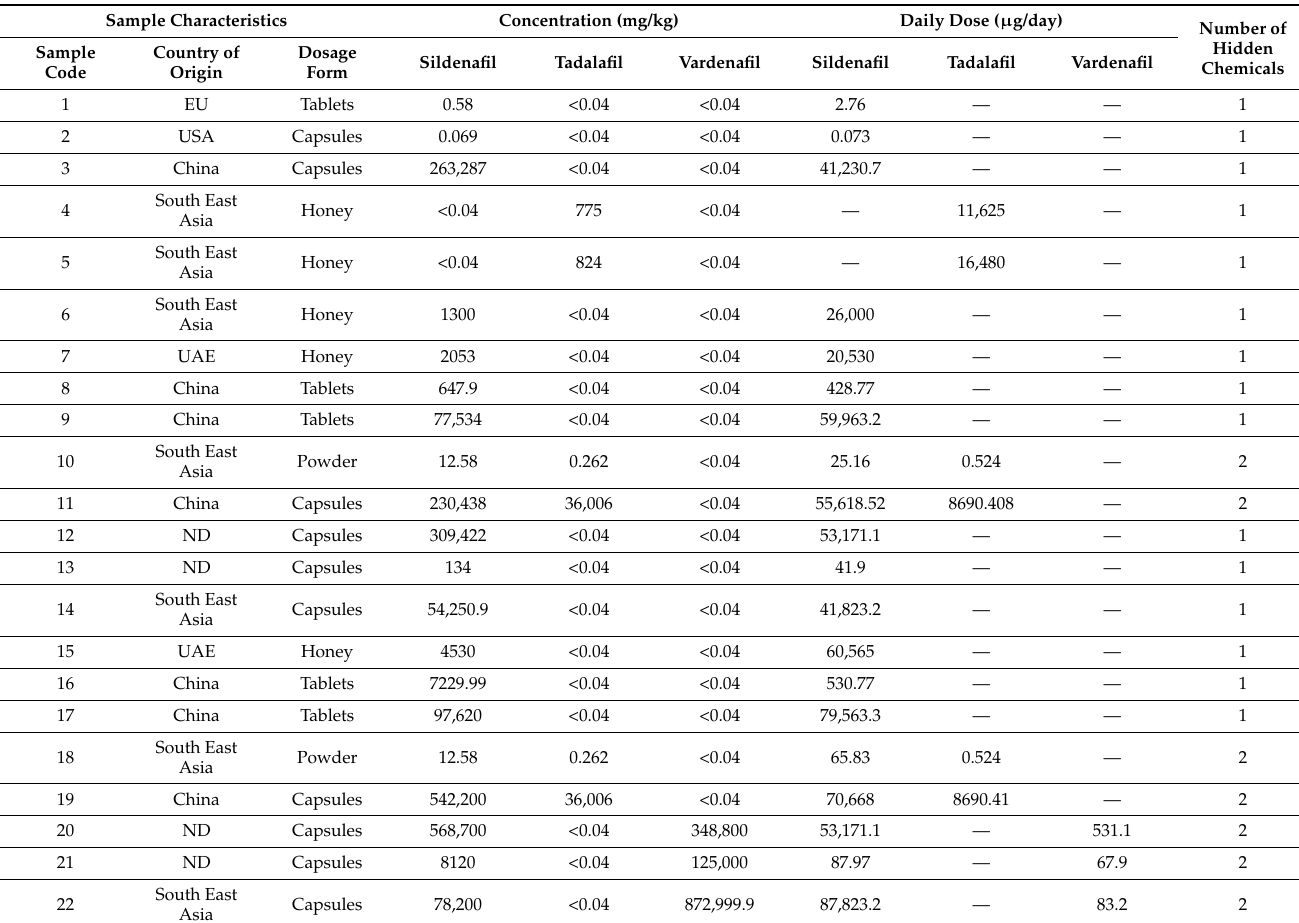
Table 3. List of tested sexual enhancement supplement products according to the prescription drugs/chemicals and sample